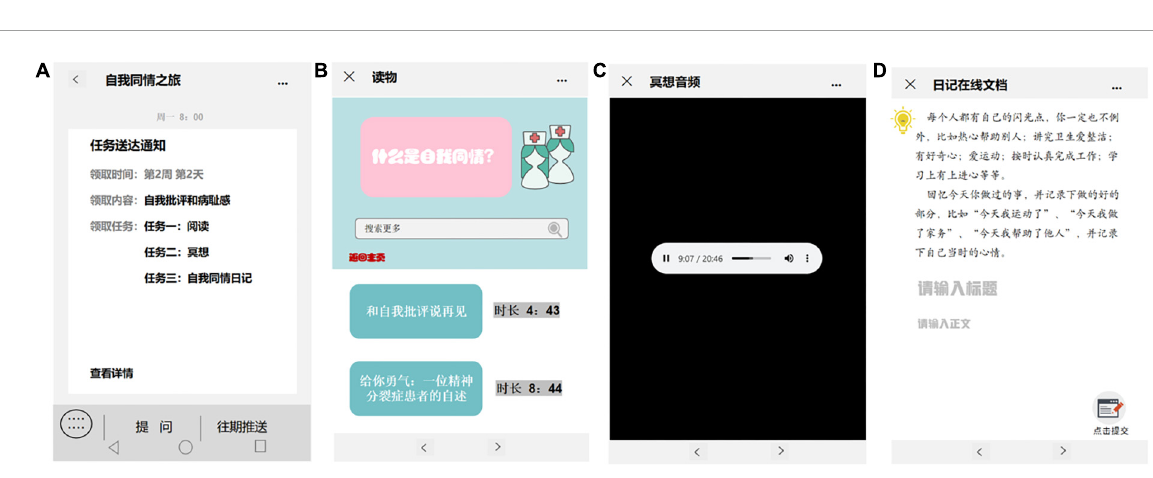
if the participant fails to complete the task before 8.00